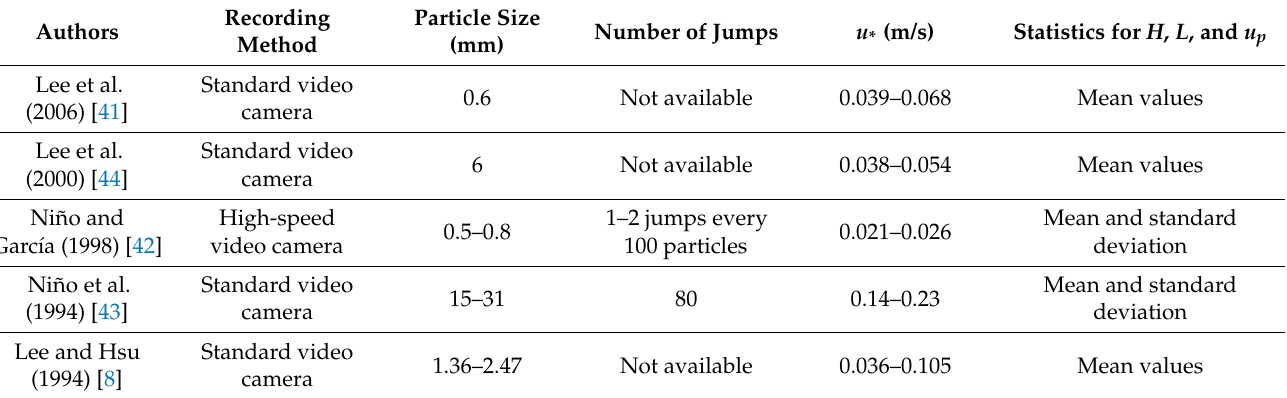
Table 1. Characteristics of experimental information for particle jumps.